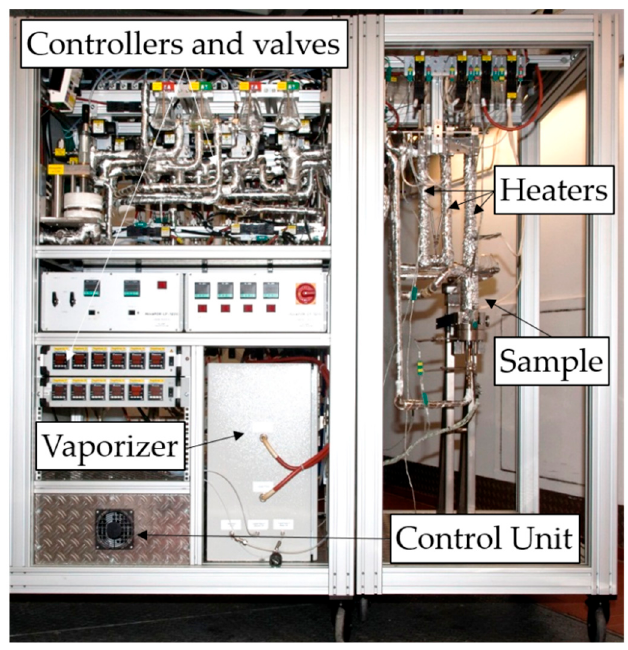
Figure 9. Picture of the laboratory gas test bench.